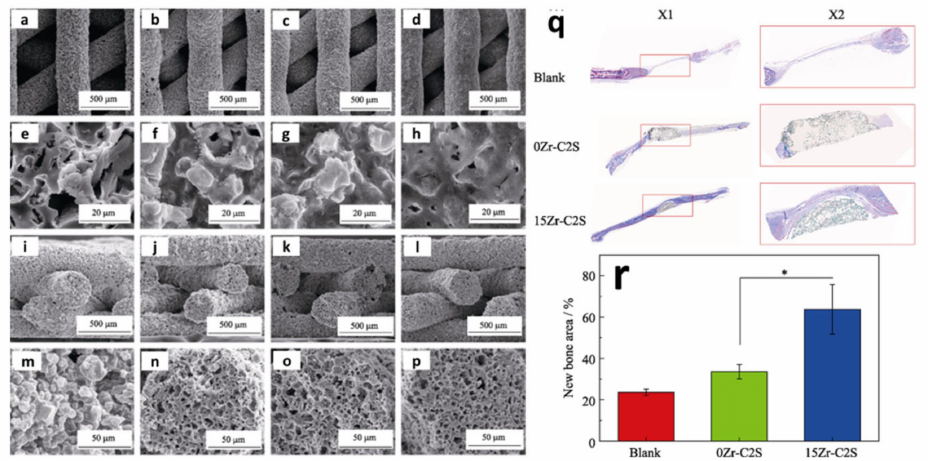
Figure 9. ( a – p ) SEM images of ( a ) 0Zr-C2S, ( b ) 5Zr-C2S, ( c ) 10Zr-C2S and ( d ) 15Zr-C2S scaffolds, with SEM fracture surface images from ( i,m ) to ( i – p ). In vivo results for 0Zr-C2S and 15Zr-C2S scaffolds ( q ) histological and ( r ) quantitative analysis results for newly formed bone. Reprinted with permission from Fu et al. [80], copyright© 2019.